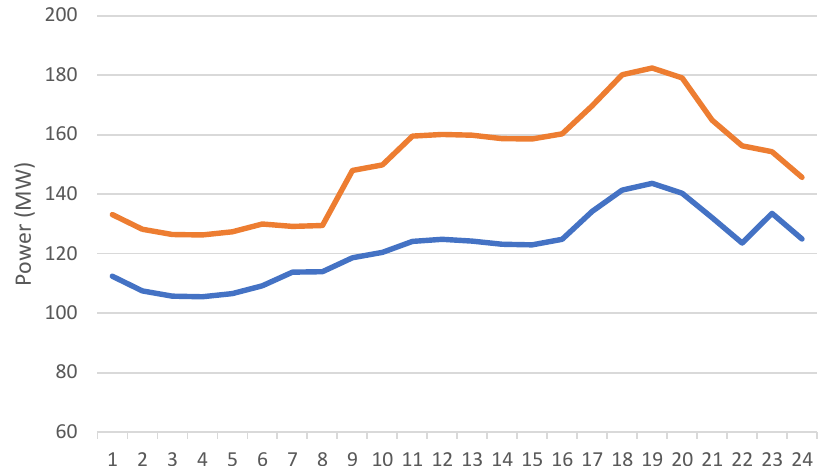
Figure 11. Impact of the additional power on the peak power date. The blue line is the average hourly power in KSS Verkko’s distribution network on the peak power date, and the red line is the average hourly power in KSS Verkko’s distribution network after the additional power from charging electric cars according to Scenario 1 has been added.